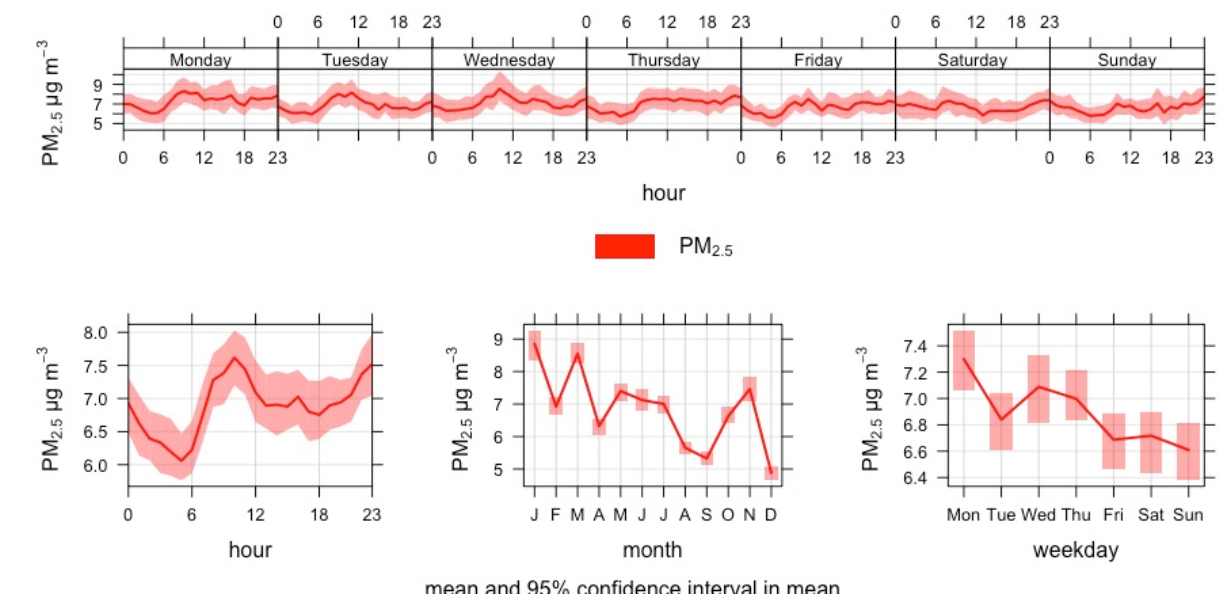
Figure 7. Time variation plot of PM 2 . 5 concentration at Vuosaari port terminal of Helsinki. The multivariable linear regression shows a statistically significant association for arrivals and vessels at berth with the natural logarithm of hourly mean PM 2.5 concentrations. However, arrivals during the weekends are not statistically significant and the coefficient is negative. A similar result is observed for vessels at berth: the association is statistically significant for the whole year and for the weekends, but the coefficient is positive for the whole year and negative for the weekends (Table 5). The models for the whole year explain 13% and the models for the weekends explain 15% of the variation in the hourly logPM 2 . 5 . The diagnostic plots (supplement) show an uneven distribution of the model